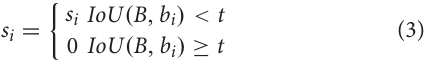
layer and regression layer. The former outputs 2 k -dimension vector encoding the classification confidence (objects or not objects), and the latter outputs 4 k -dimension vector encoding the